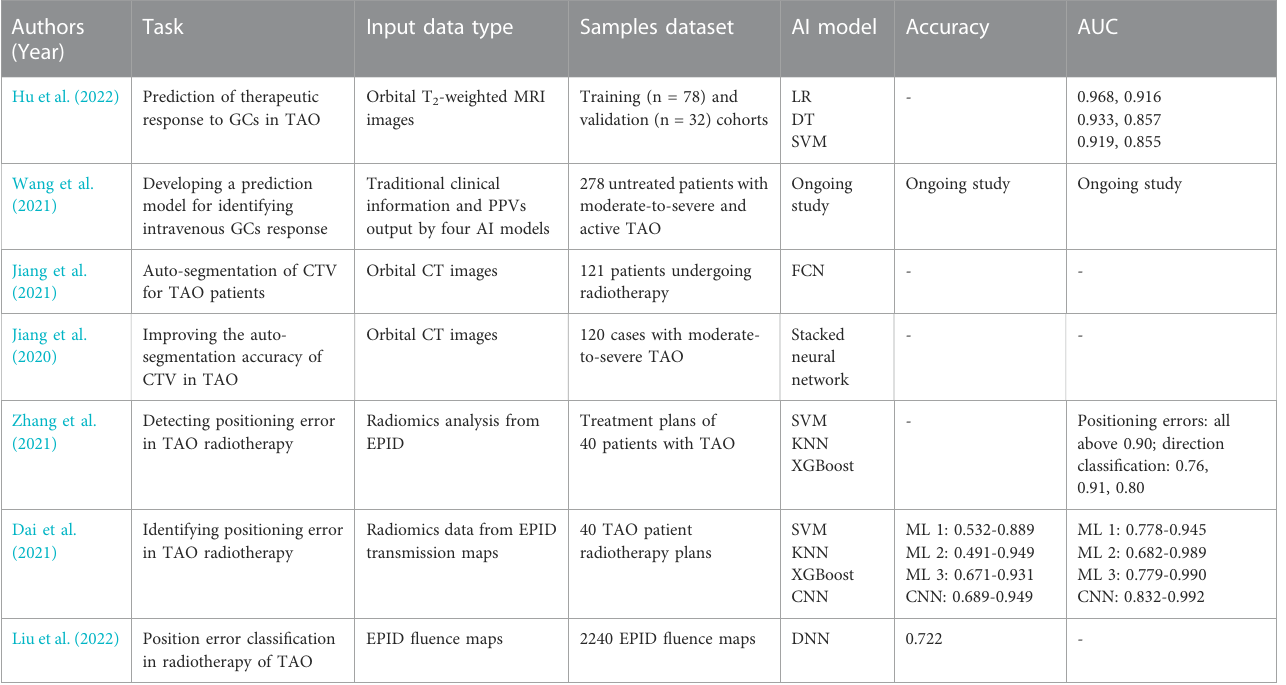
TABLE 2 AI algorithms in treatment of TAO. Authors